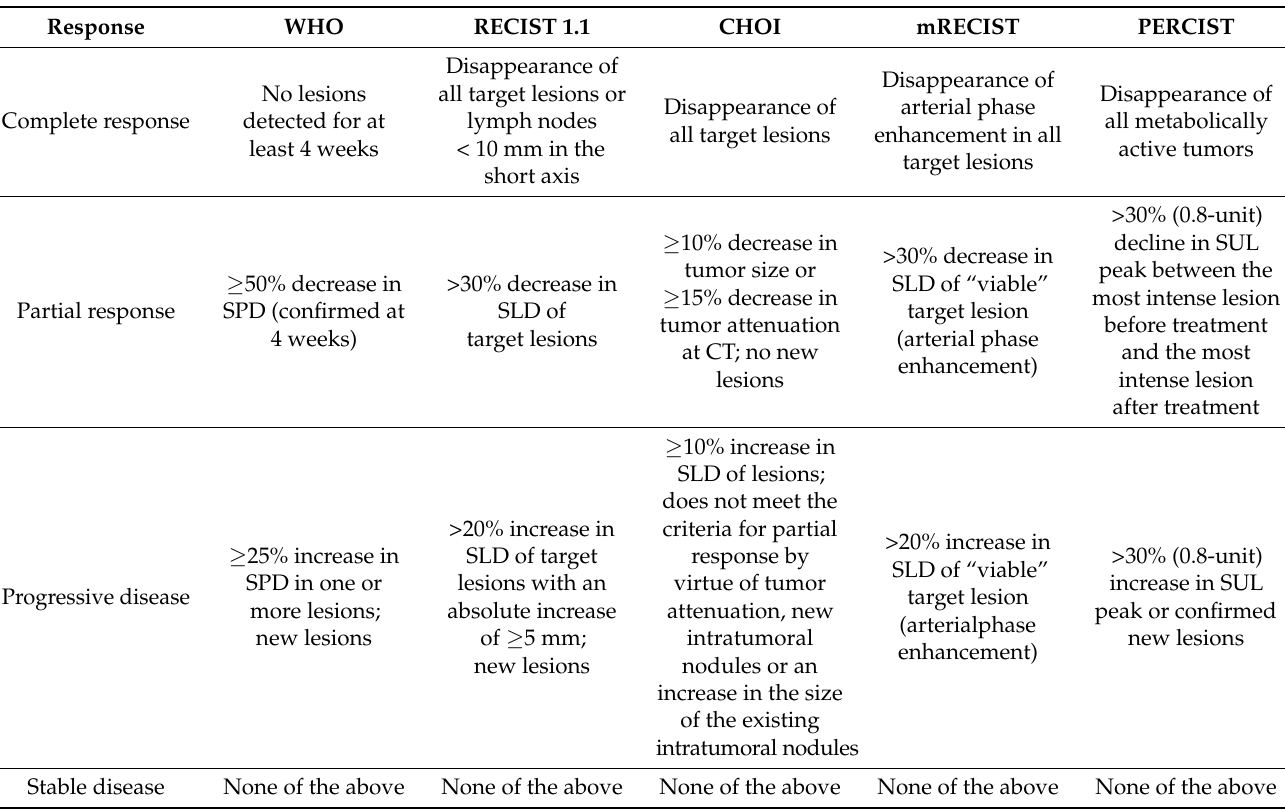
Table 1. Comparison of WHO, RECIST 1.1, Choi, mRECIST, PERCIST